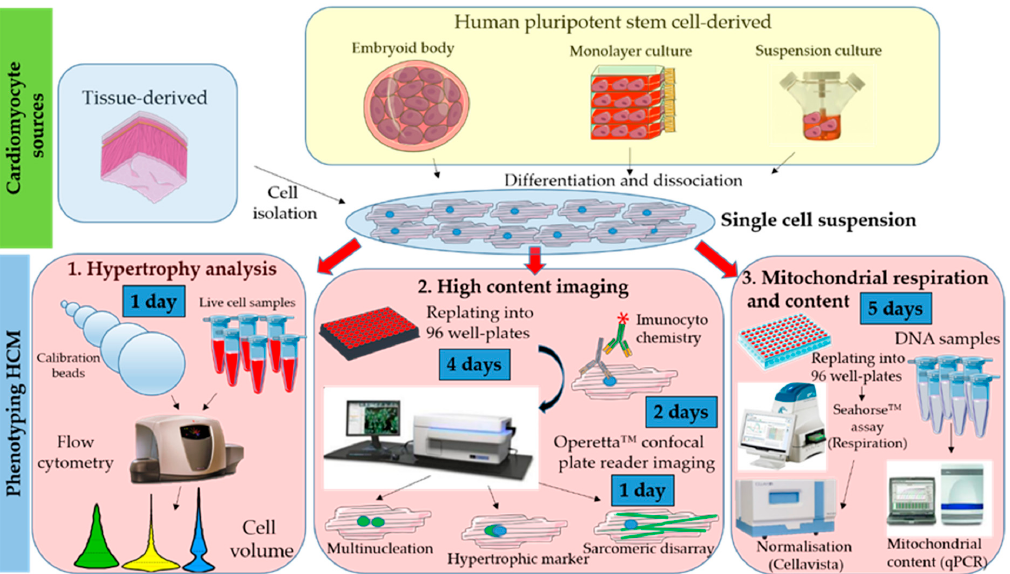
Figure 1. Workflow showing toolkit for phenotyping hypertrophic cardiomyopathy (HCM) in cellular models. Cardiomyocytes can be obtained from different sources (biopsies or cell lines) and require dissociation into a single cell suspension prior to phenotyping. Evaluation of in vitro hallmarks of HCM is done via: (1) Flow volumetry to investigate hypertrophy; (2) high-content imaging to assess multinucleation, brain natriuretic peptide (BNP) hypertrophic marker expression, and sarcomeric disarray; (3) Seahorse assay and qPCR to assess mitochondrial respiration and content, respectively.